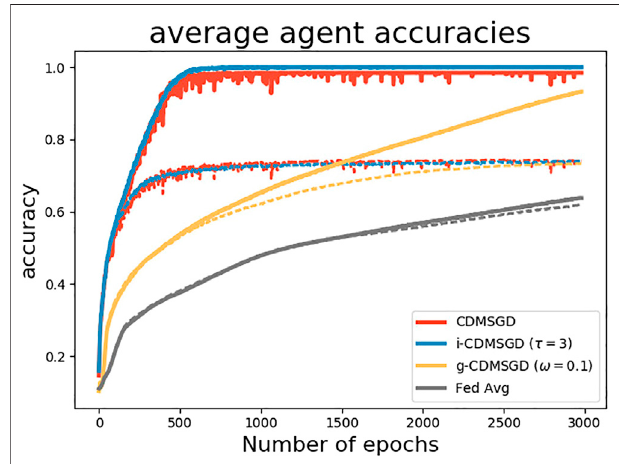
FIGURE2| Performanceofdifferentalgorithmswithunbalancedsample distribution among agents (Dashed lines represent test accuracy and solid lines represent training